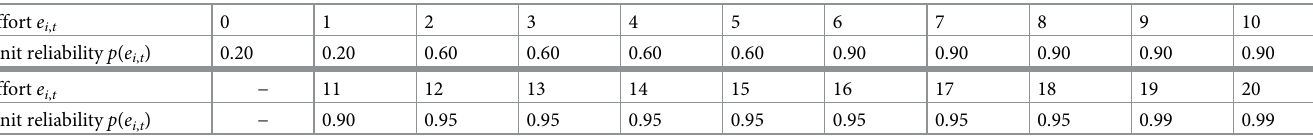
Table 1. Relation between effort and unit reliability.